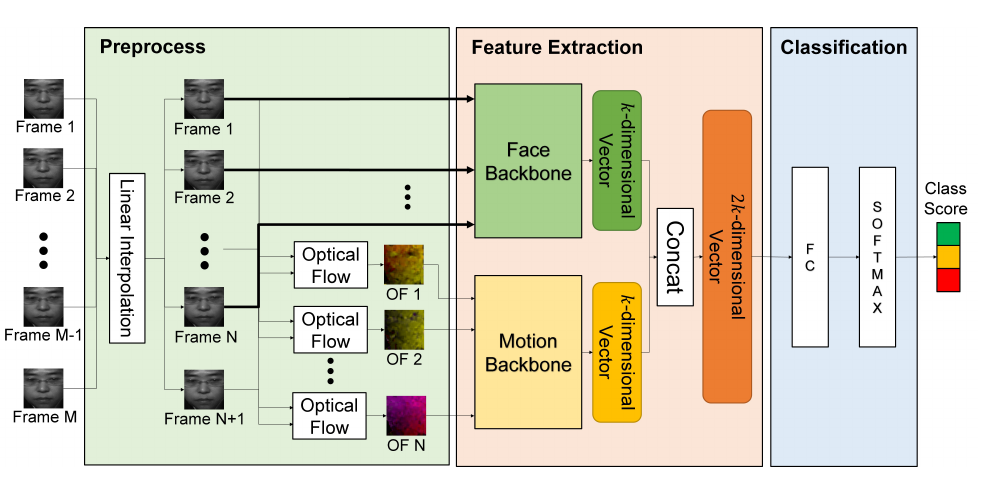
Figure 1. Structure of proposed